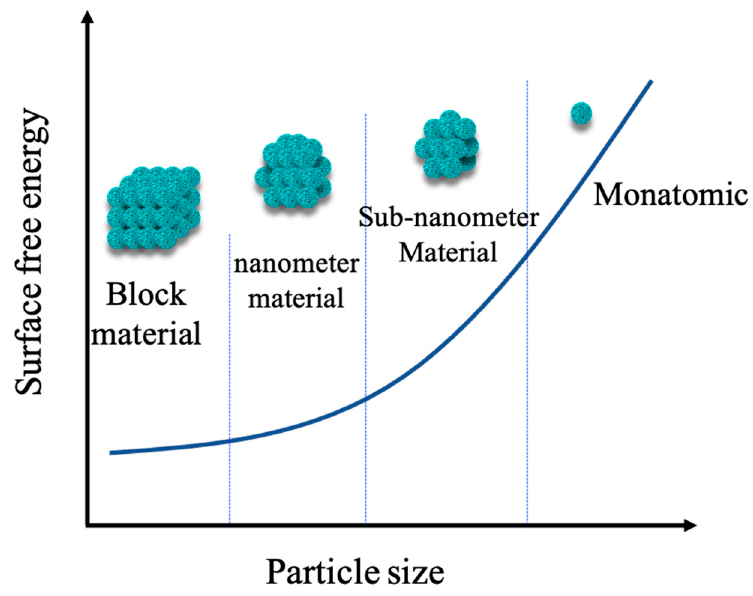
Figure 8. Relationship between particle size and surface free energy.